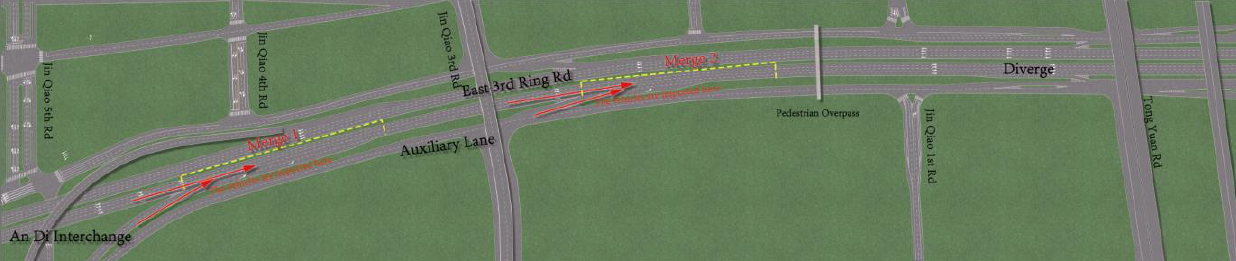
Figure 8. Survey road satellite map.